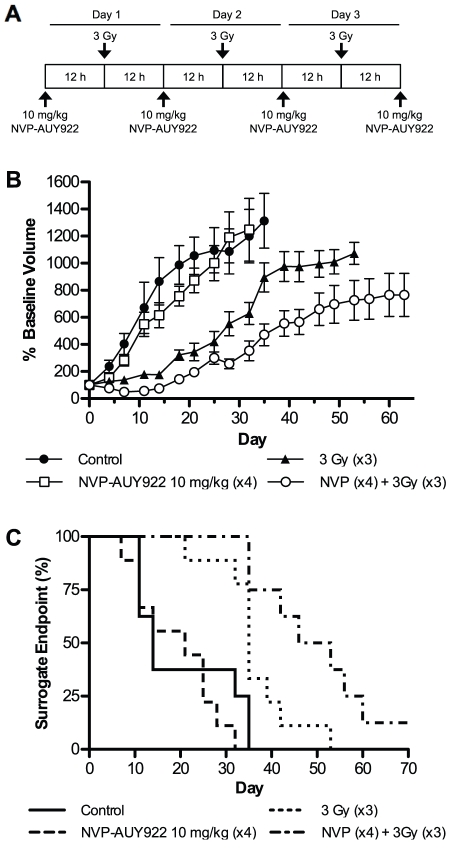
Sub-optimal dosing of NVP-AUY922 delays tumor growth and increases time to surrogate endpoint in vivo in conjunction with ionising radiation.Radiosensitization due to NVP-AUY922 was assessed in vivo in a human xenograft model. HN3 cells were allowed to achieve a tumor volume of 5–8 mm after implantation in the right flank and evenly distributed into four treatment groups with matching average tumor volumes; vehicle only control (n = 8); NVP-AUY922, four doses of 10 mg/kg each (n = 9); 9 Gy ionising radiation fractionated in three doses of 3 Gy (n = 9); NVP-AUY922 and ionising radiation (n = 8). (A) Scheduling of four rounds of 10 mg/kg NVP-AUY922 or vehicle only was administered by interperitonal injection, followed by fractioned tumor-targeted radiotherapy of 3 Gy each to a cumulative total of 9 Gy on days one to three. Tumor sizes were measured every 3–4 days with resulting percentage baseline tumor volume (B) and percentage surrogate endpoint (C) shown. Data represents ± SEM. Mantel-Cox log-rank test carried out for statistical analysis of surrogate endpoint data (p = 0.0002).